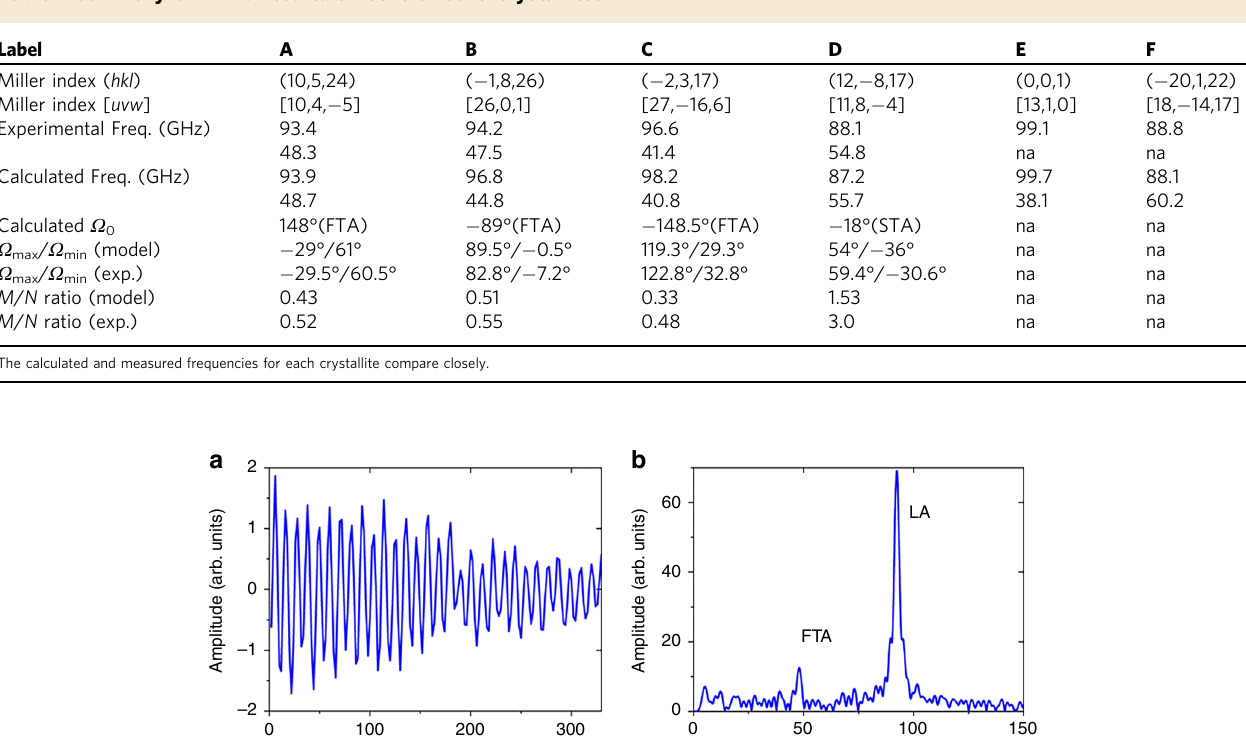
Table 1 Summary of TDBS results on several ceria crystallites.